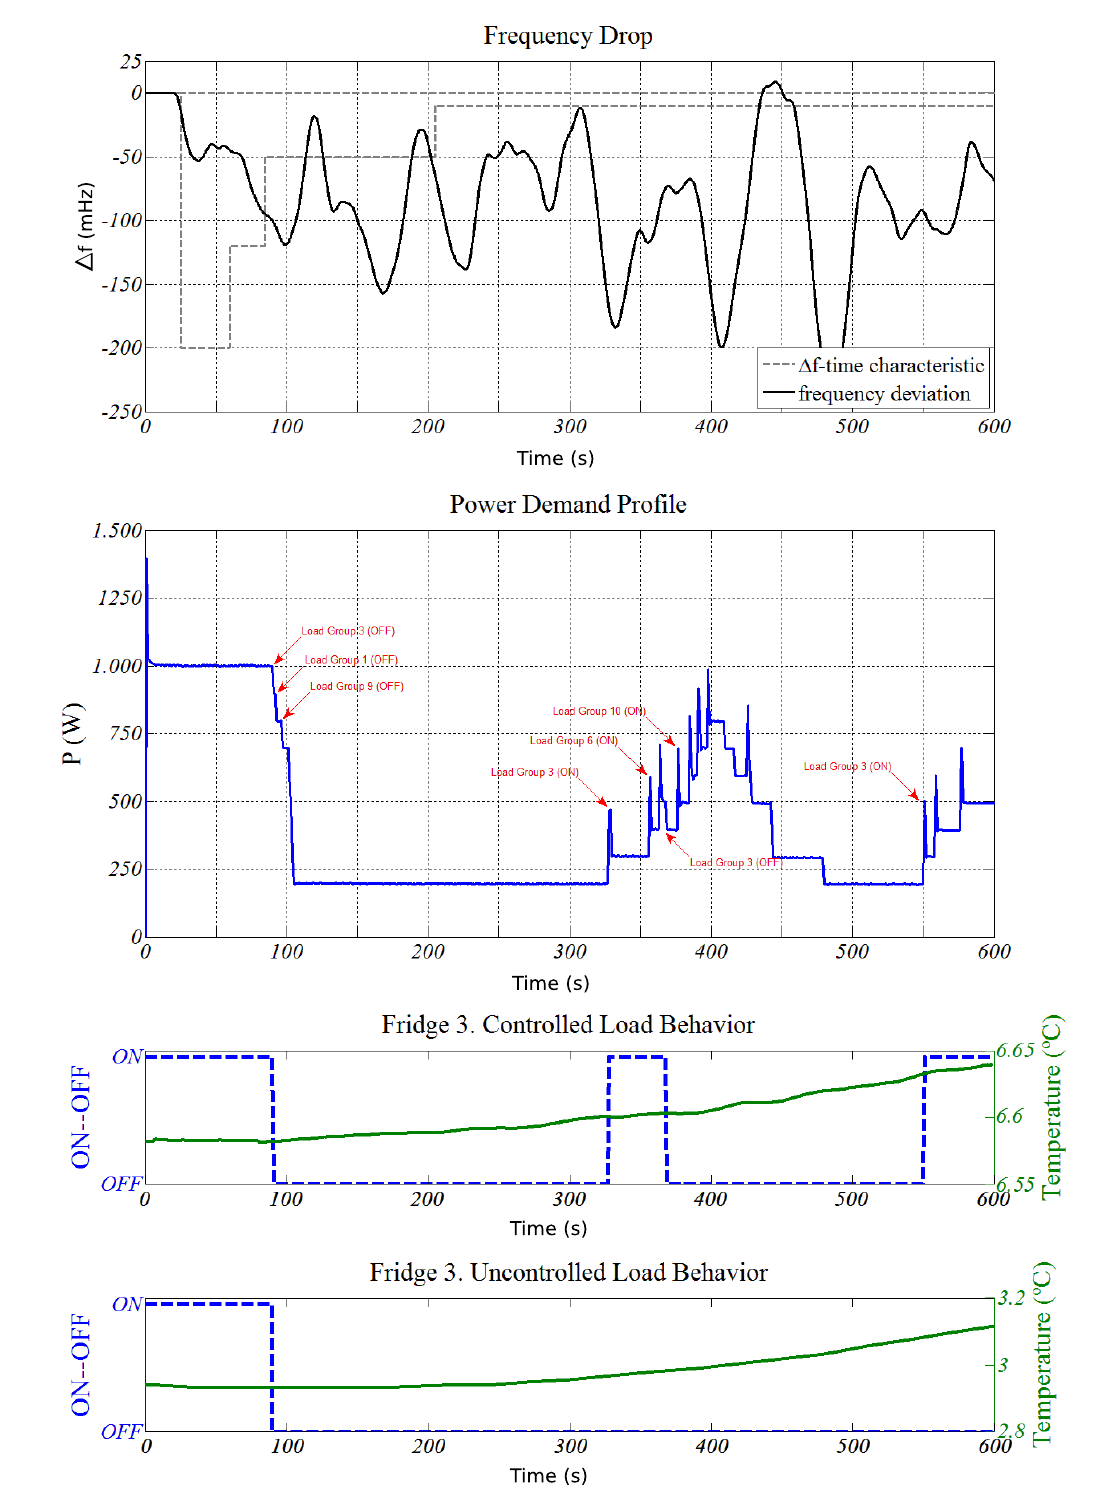
Figure 12. Case Study (II). Aggregate power demand profile and example of fridge temperature evolution. The maximum disconnection time period is in line with the controlled temperature and the comfort levels fixed by customers. For the case studies, internal temperature modifications are limited to 0.2 ◦ C ( t maxOFF = 5 min). Consequently, the maximum temperature increases caused by